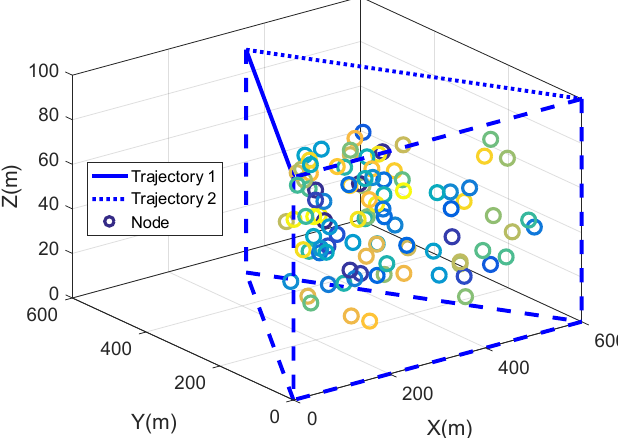
Figure 11. The network system architecture in the